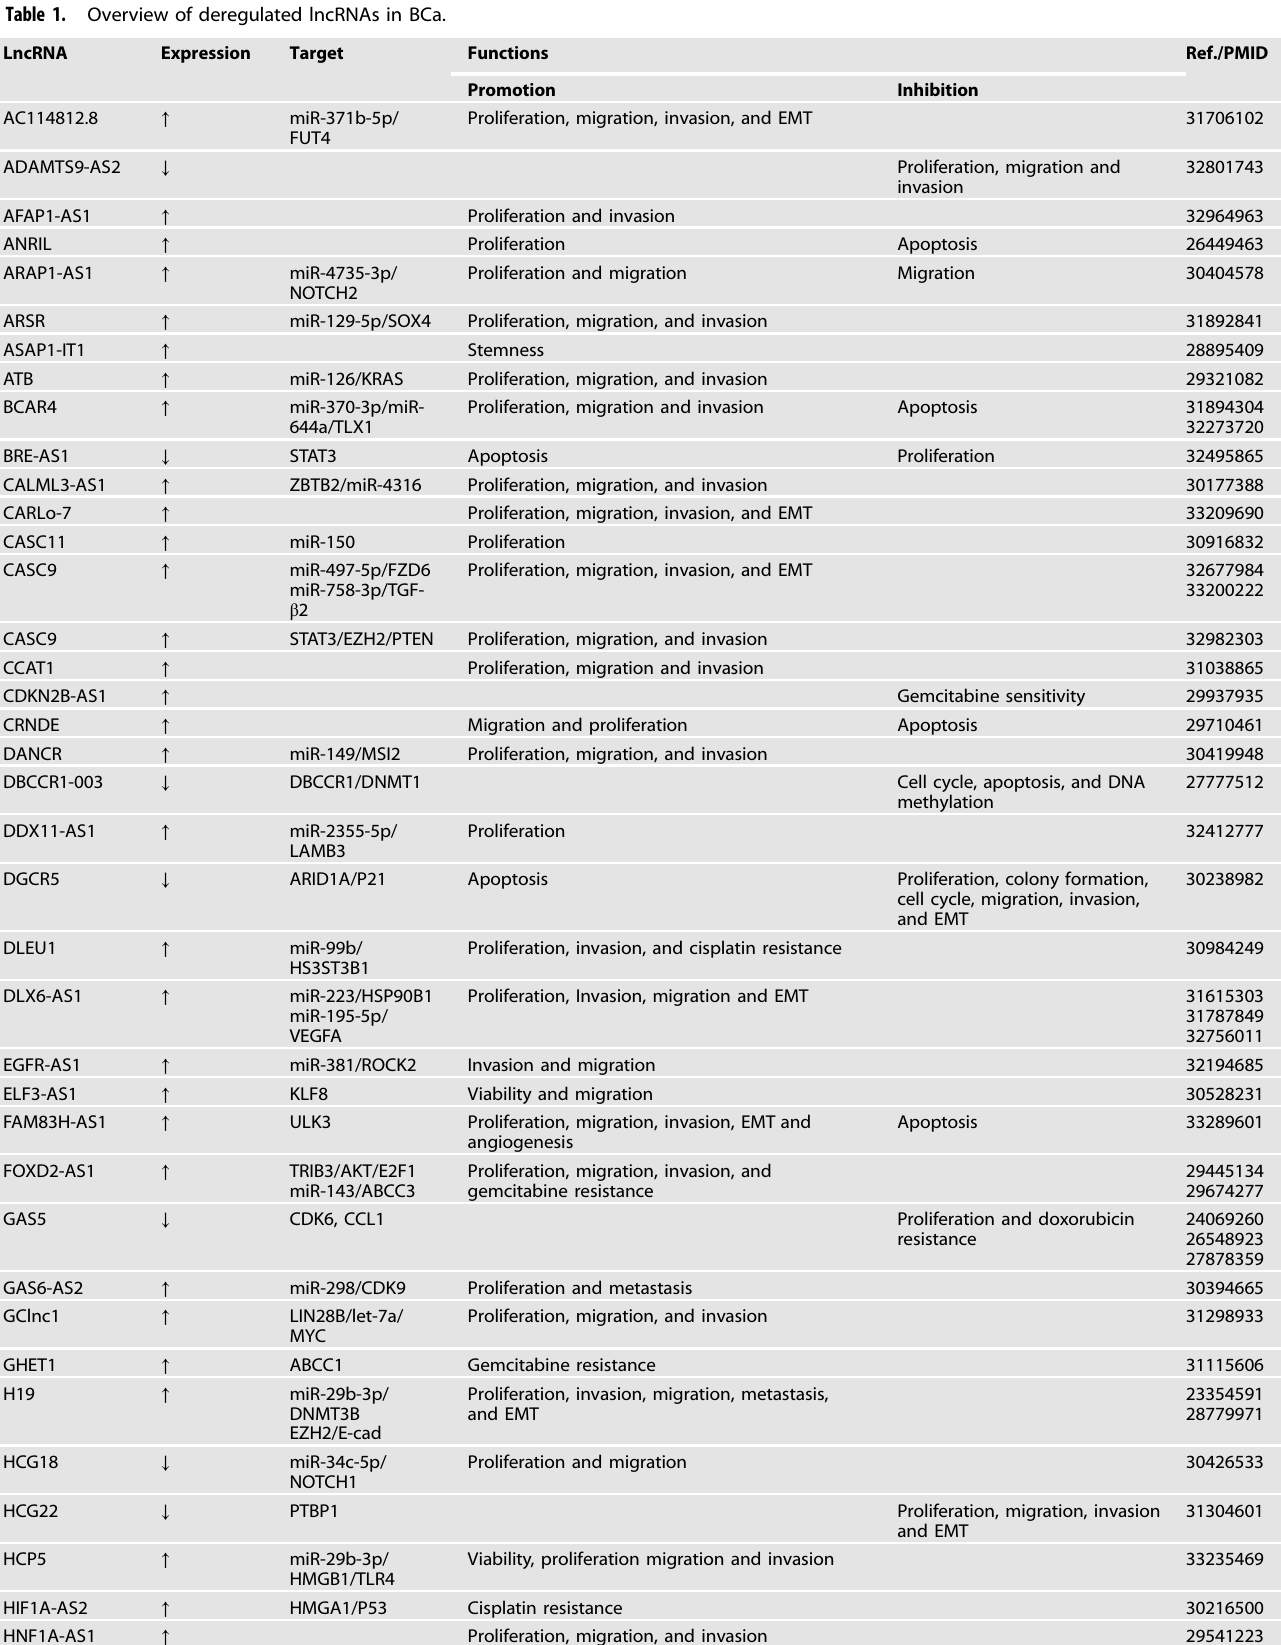
Table 1. Overview of deregulated lncRNAs in BCa.